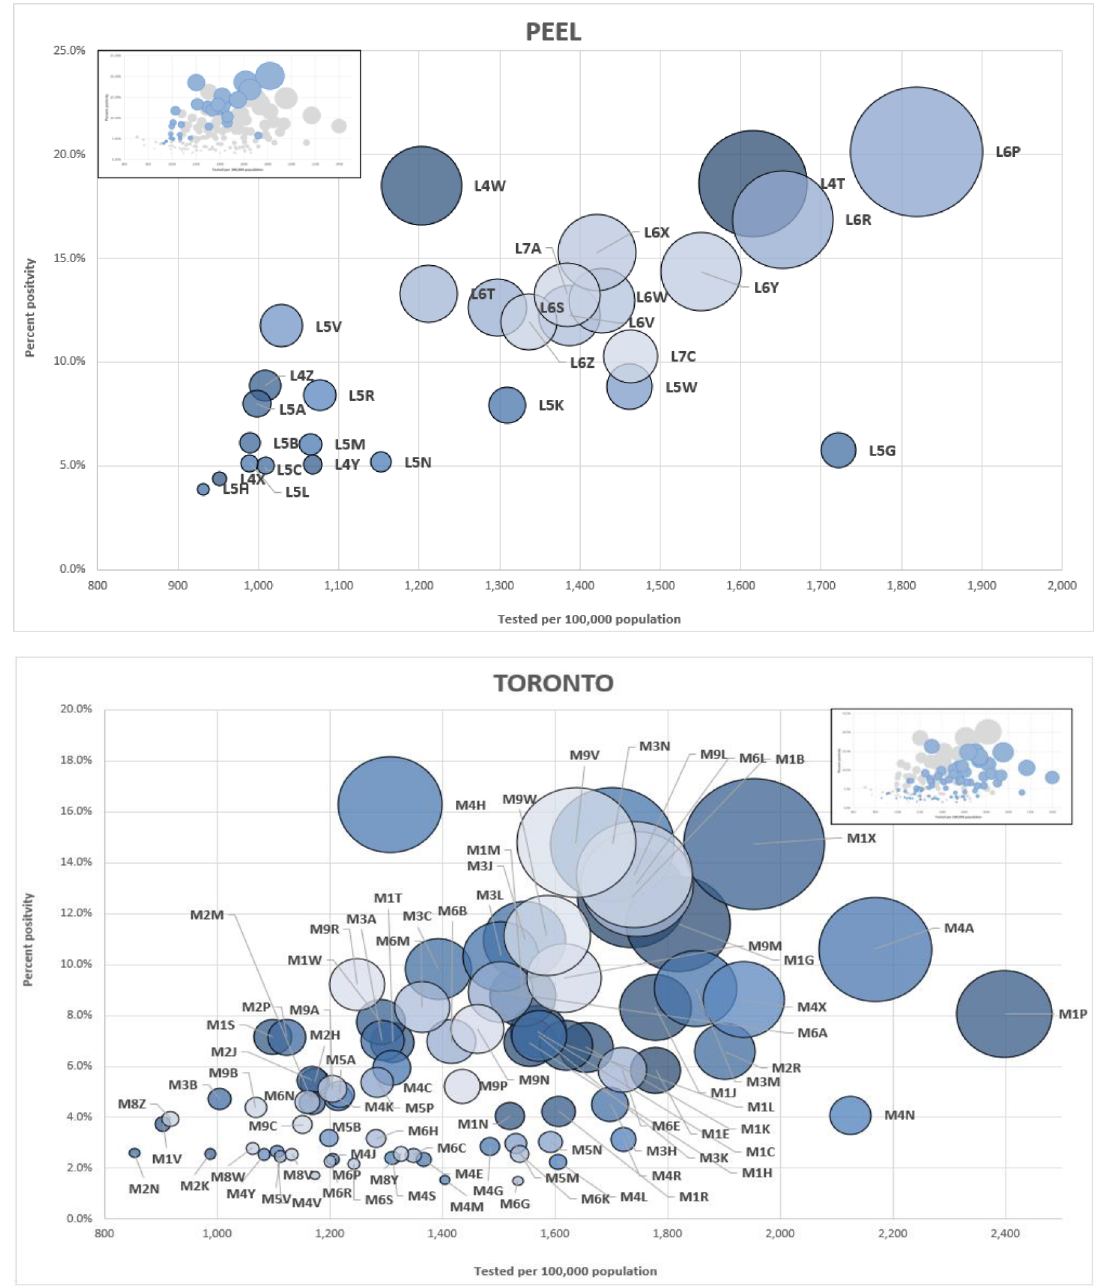
Figure 2: Example exhibits on SARS-CoV-2 testing from ICES COVID-19 Dashboard ‡ - Per capita testing and percent positivity for COVID-19 by Forward Sortation Areas (FSA) in selected Public Health Units in Ontario for the week of 8 th to 14 th